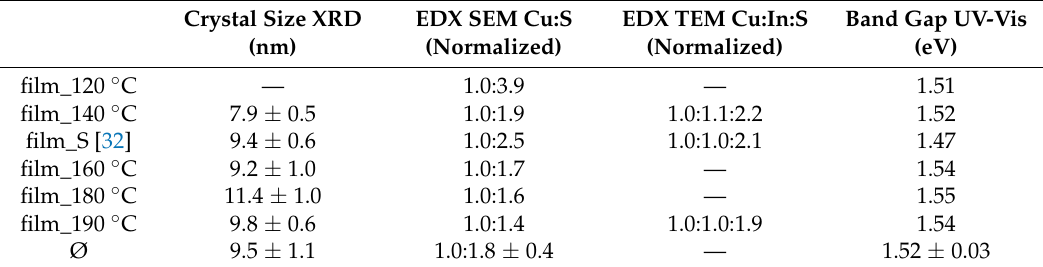
Table 2. Summary of crystal size, determined with XRD, normalized elemental composition (Cu:S for SEM, Cu:In:S for STEM measurements) and band gap of the CuInS 2 films synthesized with L -cysteine at different reaction temperatures for 18 h. Values of film_120 ◦ C are not included in the average value in the last row.